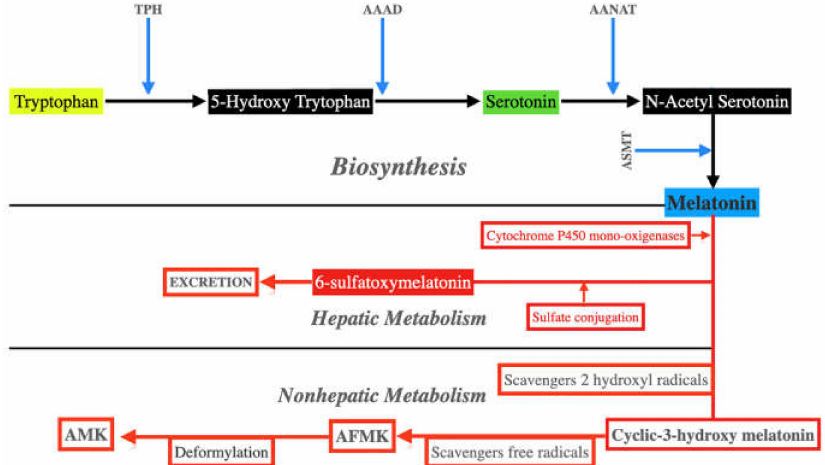
Figure 3. Synthesis and metabolism of melatonin. Melatonin biosynthesis first requires the hydroxy- lation and decarboxylation of tryptophan. This leads to the formation of serotonin, which, after being acetylated, is methylated and becomes melatonin. Melatonin metabolism takes place in the liver, from where it is excreted, and also in non-hepatic sites; in this case, the transformation of melatonin occurs non-enzymatically after free radical scavenging, giving rise to forms with even more powerful antiox- idant activity than melatonin itself, such as cyclic 3-hydroxymelatonin and AFMK. In turn, AFMK can undergo deformylation resulting in the strong antioxidant AMK. TPH: tryptophan hydroxylase. AAAD: aromatic L-amino acid decarboxylase; AANAT: aryl alkylamine N -acetyl transferase.